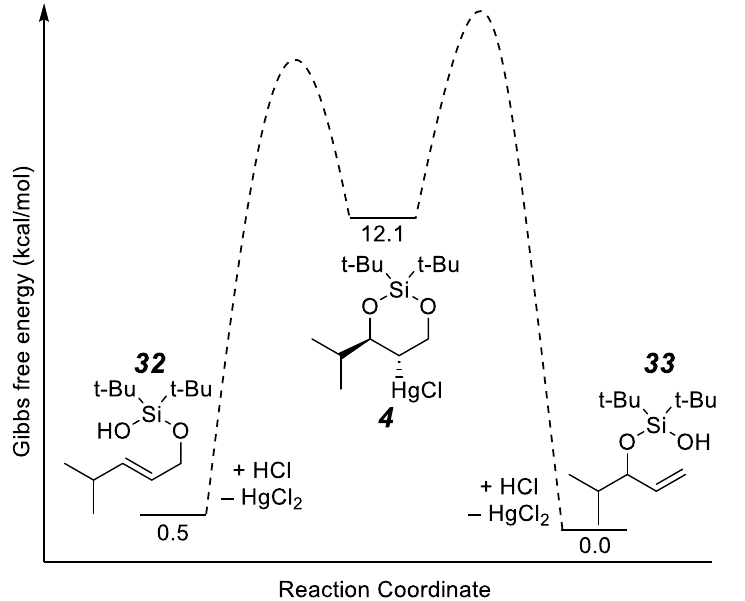
Figure 2. Calculated thermodynamics for isopropyl substrate 4.